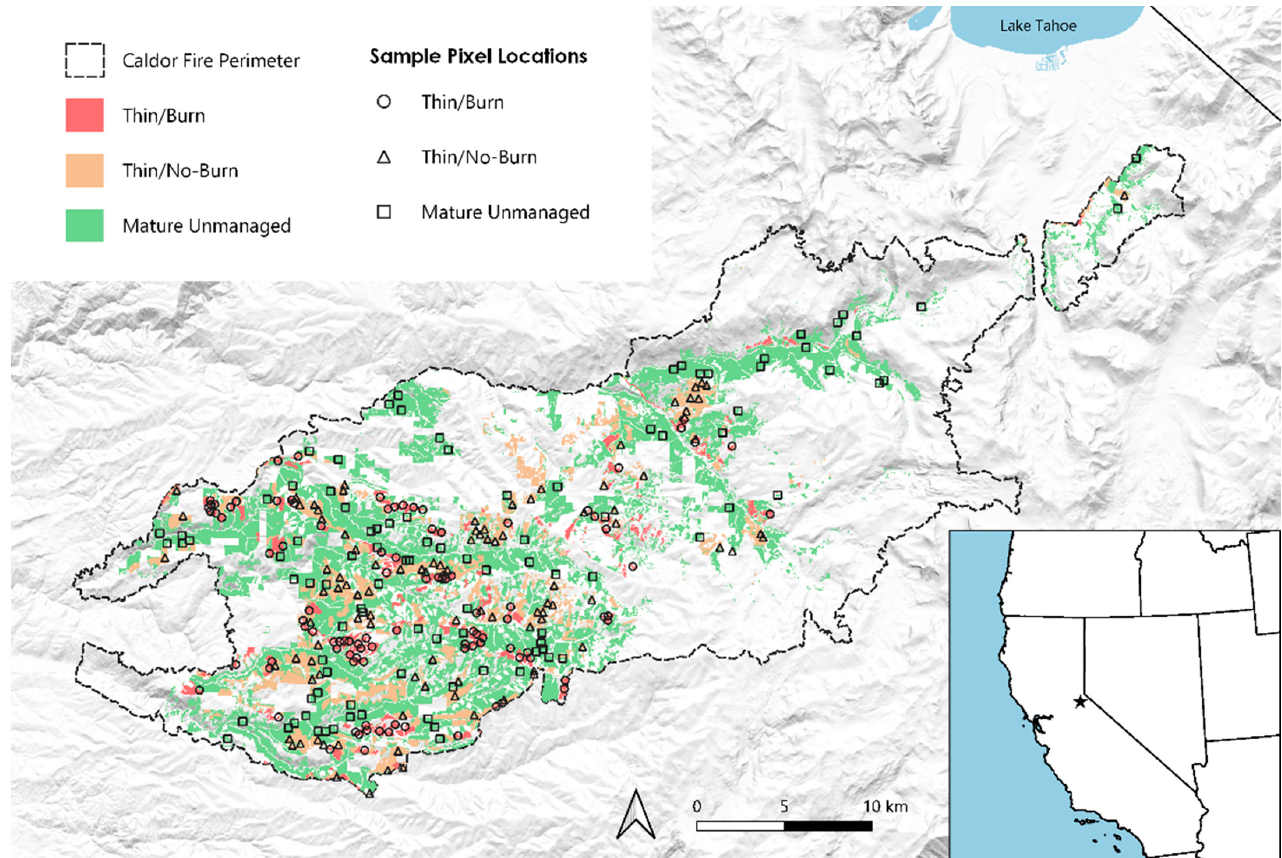
Figure 1. The Caldor Fire study area. Unshaded areas within the fire perimeter were either not the vegetation type we examined and/or were not managed by the U.S. Forest Service. The star in the overview map represents the approximate location of the fire.